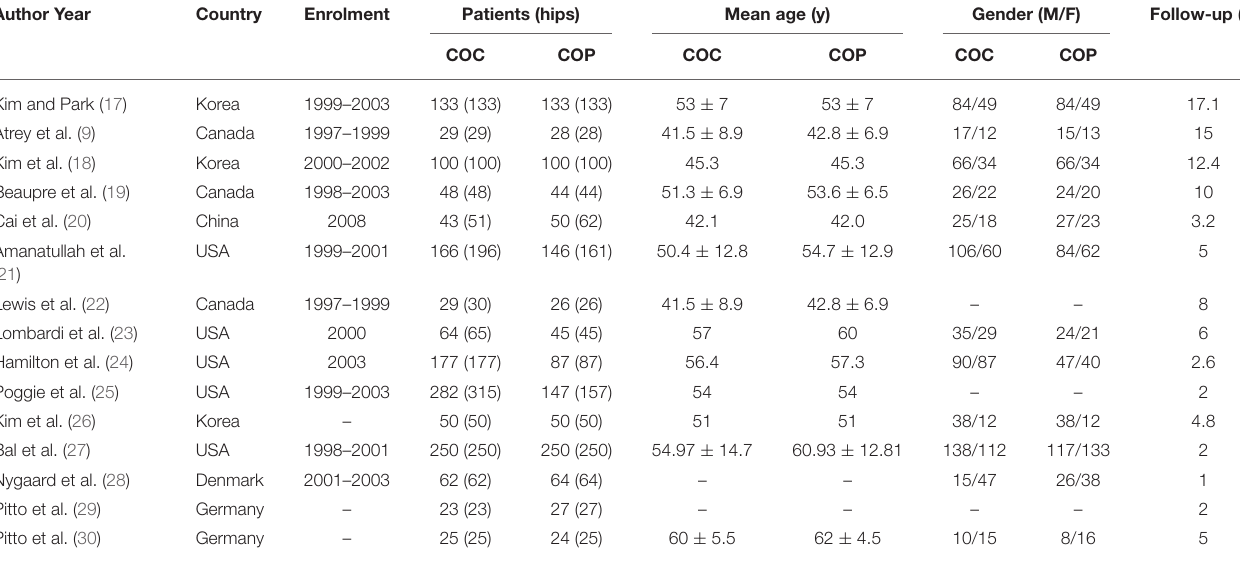
TABLE 1 | Characteristics of